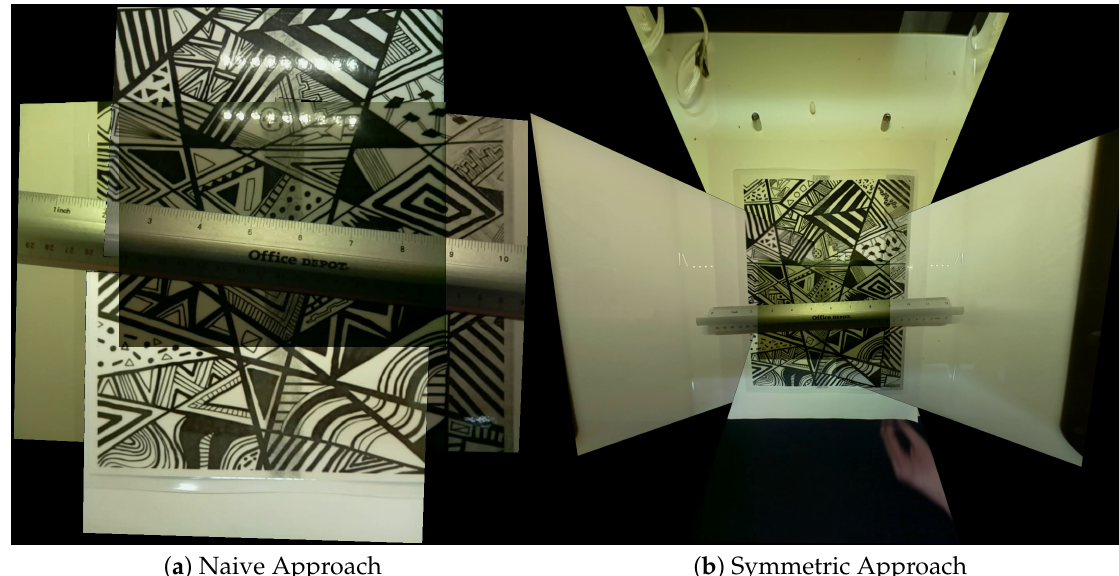
Figure 8. Applying symmetric optimization to create camera arrays for use in a laparoscopic trainer box can give significant improvements in total visibility for tasks in the box: ( a ) a frame from the original naive camera system; and ( b ) a similar frame from our symmetrically optimized camera system. The optimized system gives us near complete coverage of the test box. No blending techniques were applied so that the individual camera views can be easily picked out from the